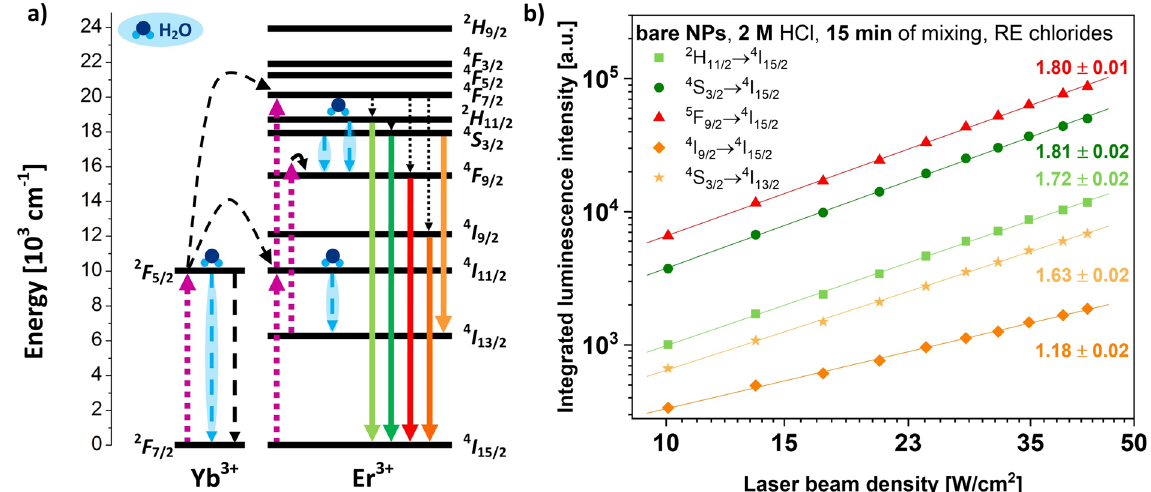
Figure 5. ( a ) Energy-level diagram for Yb 3+ and Er 3+ ions as well as proposed up-conversion mechanism (including de-excitation by water molecules) and ( b ) power-dependent slope values for Er 3+ transitions in ligand-free NaYF 4 :Yb 3+ ,Er 3+ /NaYF 4 obtained from RE chlorides and modified for 15 min by using 2-M HCl